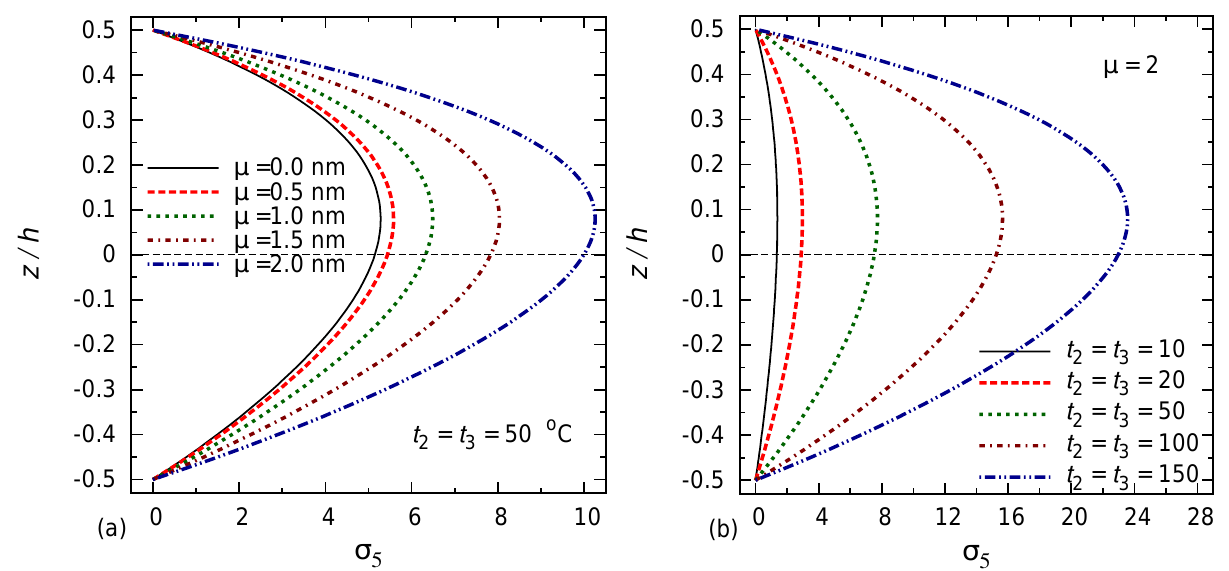
Figure 9. Effects of ( a ) the nonlocal coefficient µ and ( a ) thermal loads t 2 and t 3 on the transverse shear stress σ 5 of FG square nanoplates ( a = 10 h , κ 1 = κ 2 = 10 )